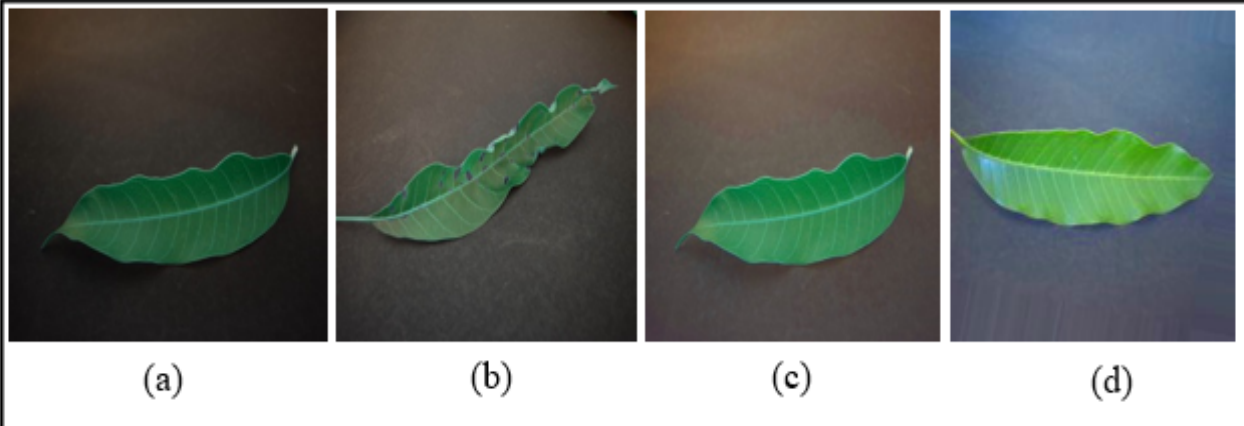
Figure 4. Sample of images present in the dataset ( a ) Healthy mango leaf, ( b ) Infected mango leaf, ( c ) Image after enhancing the brightness of 4 ( a ) image, ( d ) artificially generated mango leaf.